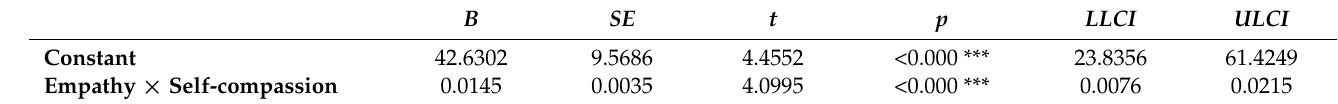
Figure 4. Model of self-compassion moderation. Table 4. Effect of empathy on happiness and self-compassion as a moderator ( N = 566).